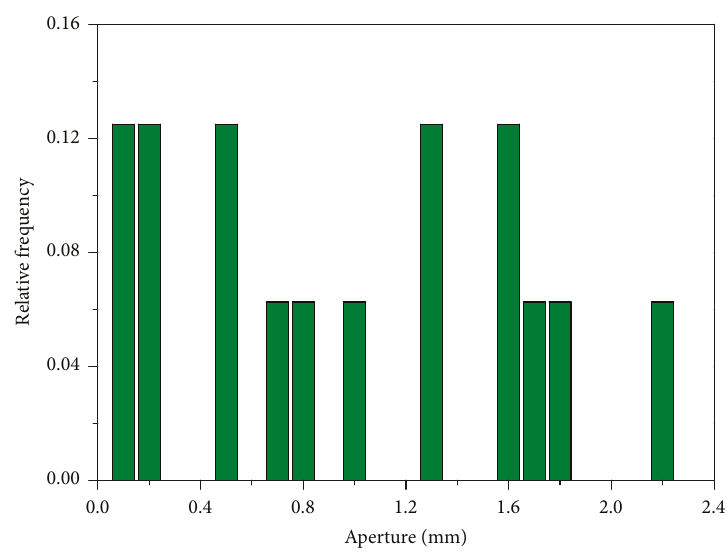
Figure 9: Distribution frequency of the aperture.